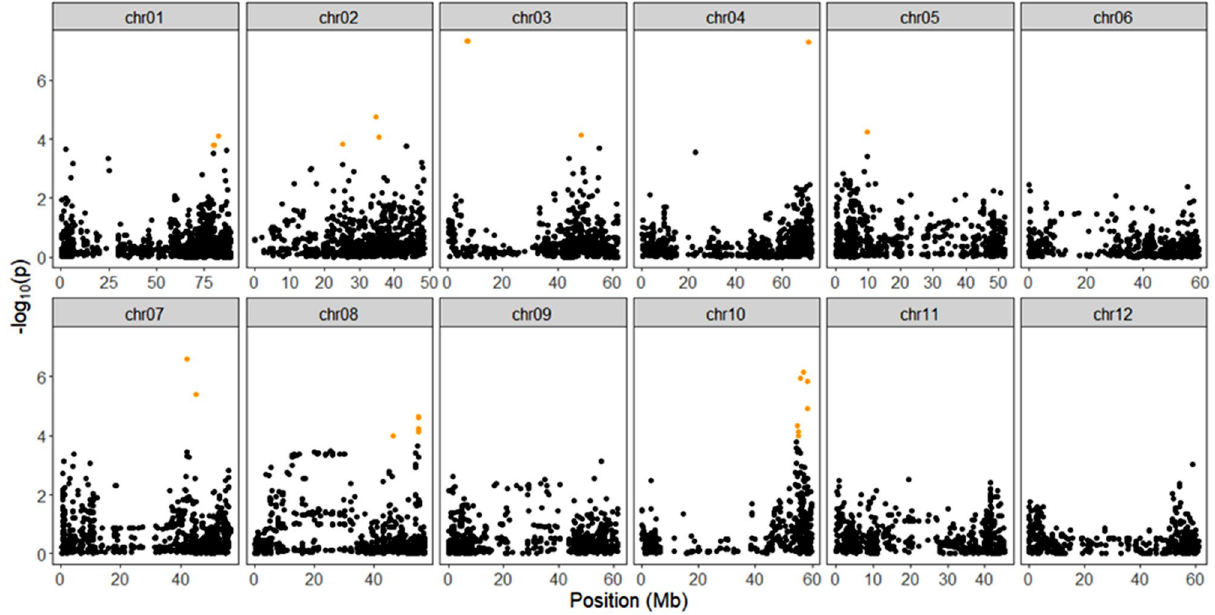
Figure 7. Manhattan plot showing the distribution of candidate outlier SNPs from PCAdapt 72 where Y-axes represent P values and significant SNPs above α = 0.05 are in orange color.